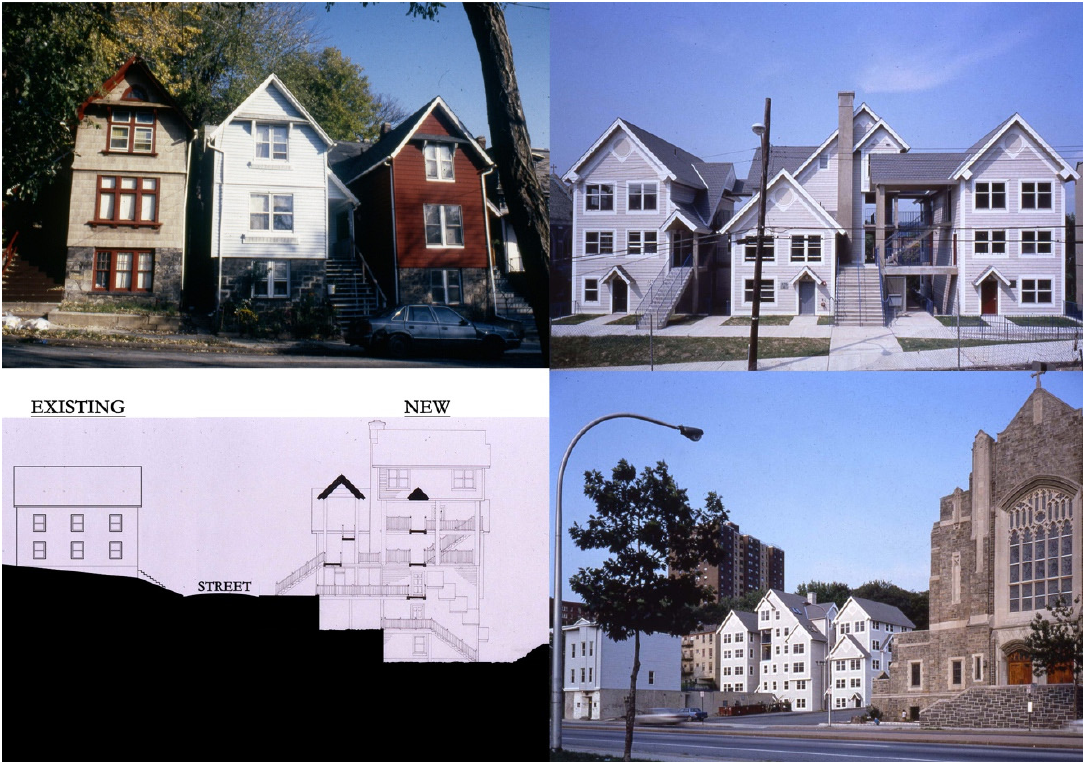
Figure 4. Context is part of “Why” in design. In two extremely divergent contexts this project created housing in Yonkers, NY in 1990.